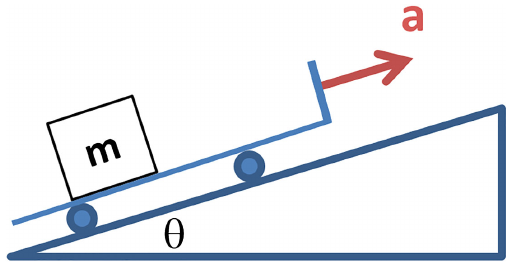
FIG. 10. Diagram provided in the prompt for version B of week 7, level 1